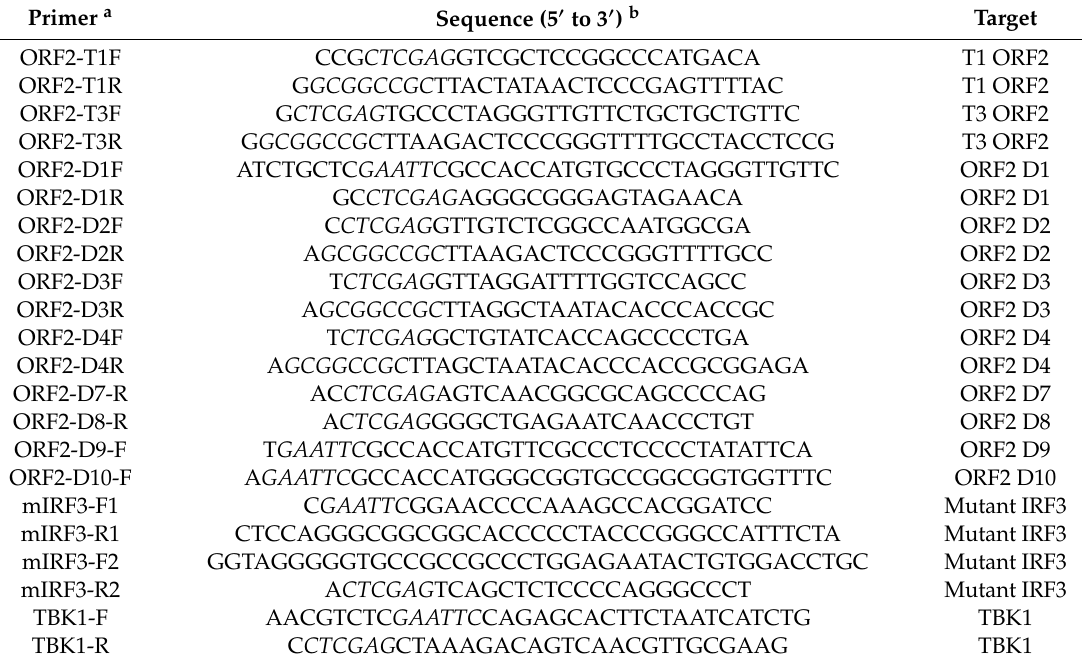
Table 1. Primers used in this